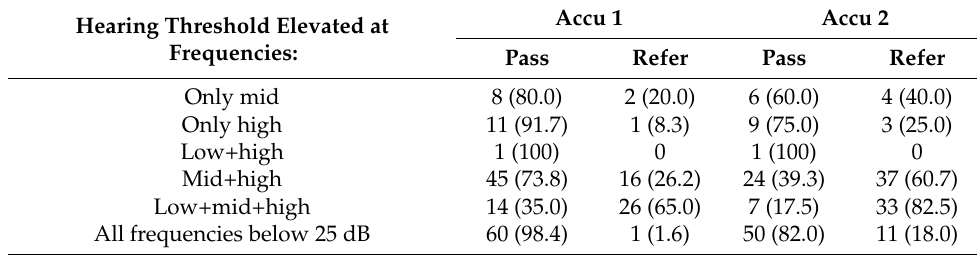
Table 2. Pass and refer rates of both Accuscreen devices in ears with hearing thresholds above 25 dB at low and/or mid and/or high frequencies. Number of ears and percent values (in parentheses) are